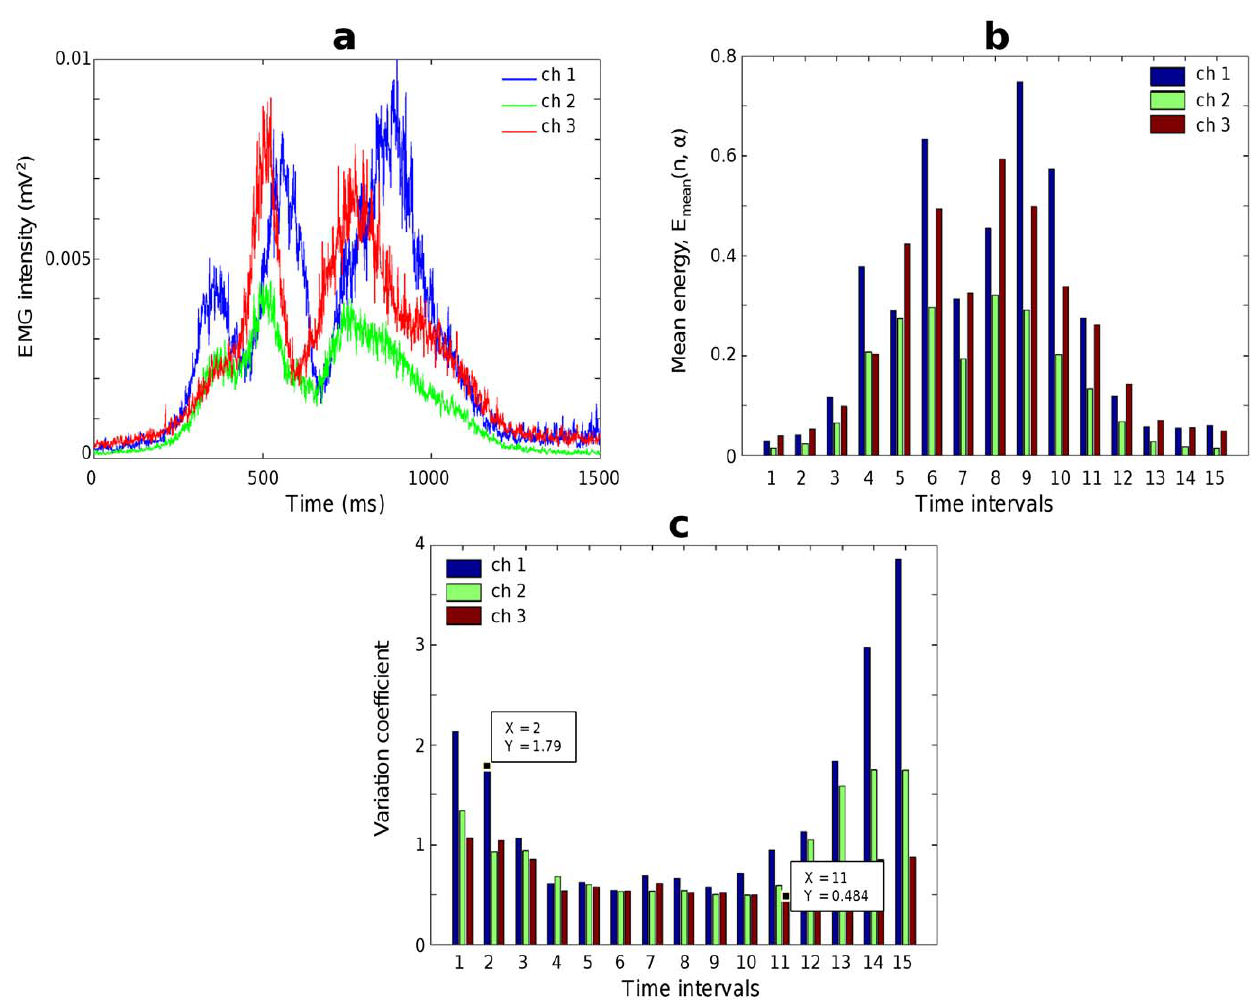
Figure 1. Statistical properties of raw EMG signals. ( a ) The intensities of raw EMG signals (digit ‘‘3’’) averaged over 412 trials (templates); the point 500 ms on the time axis corresponds to the initial moment of time when a pen touches a paper. ( b ) The mean energy of the EMG signals in time intervals; the time interval 6 corresponds to the first 100 ms of the pen-on-paper period. ( c ) The variation coefficients of the distribution of dimensionless energies E ( n , a , j ) .